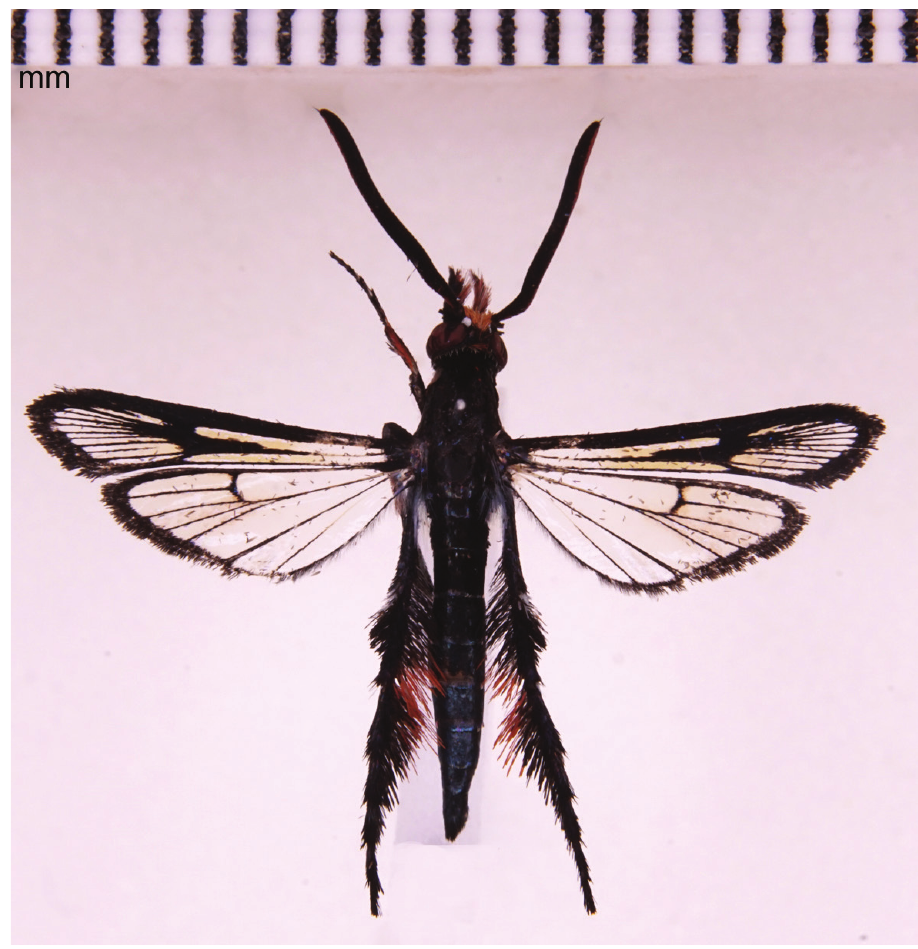
Figure 3. Male holotype of Pyrophleps ellawi